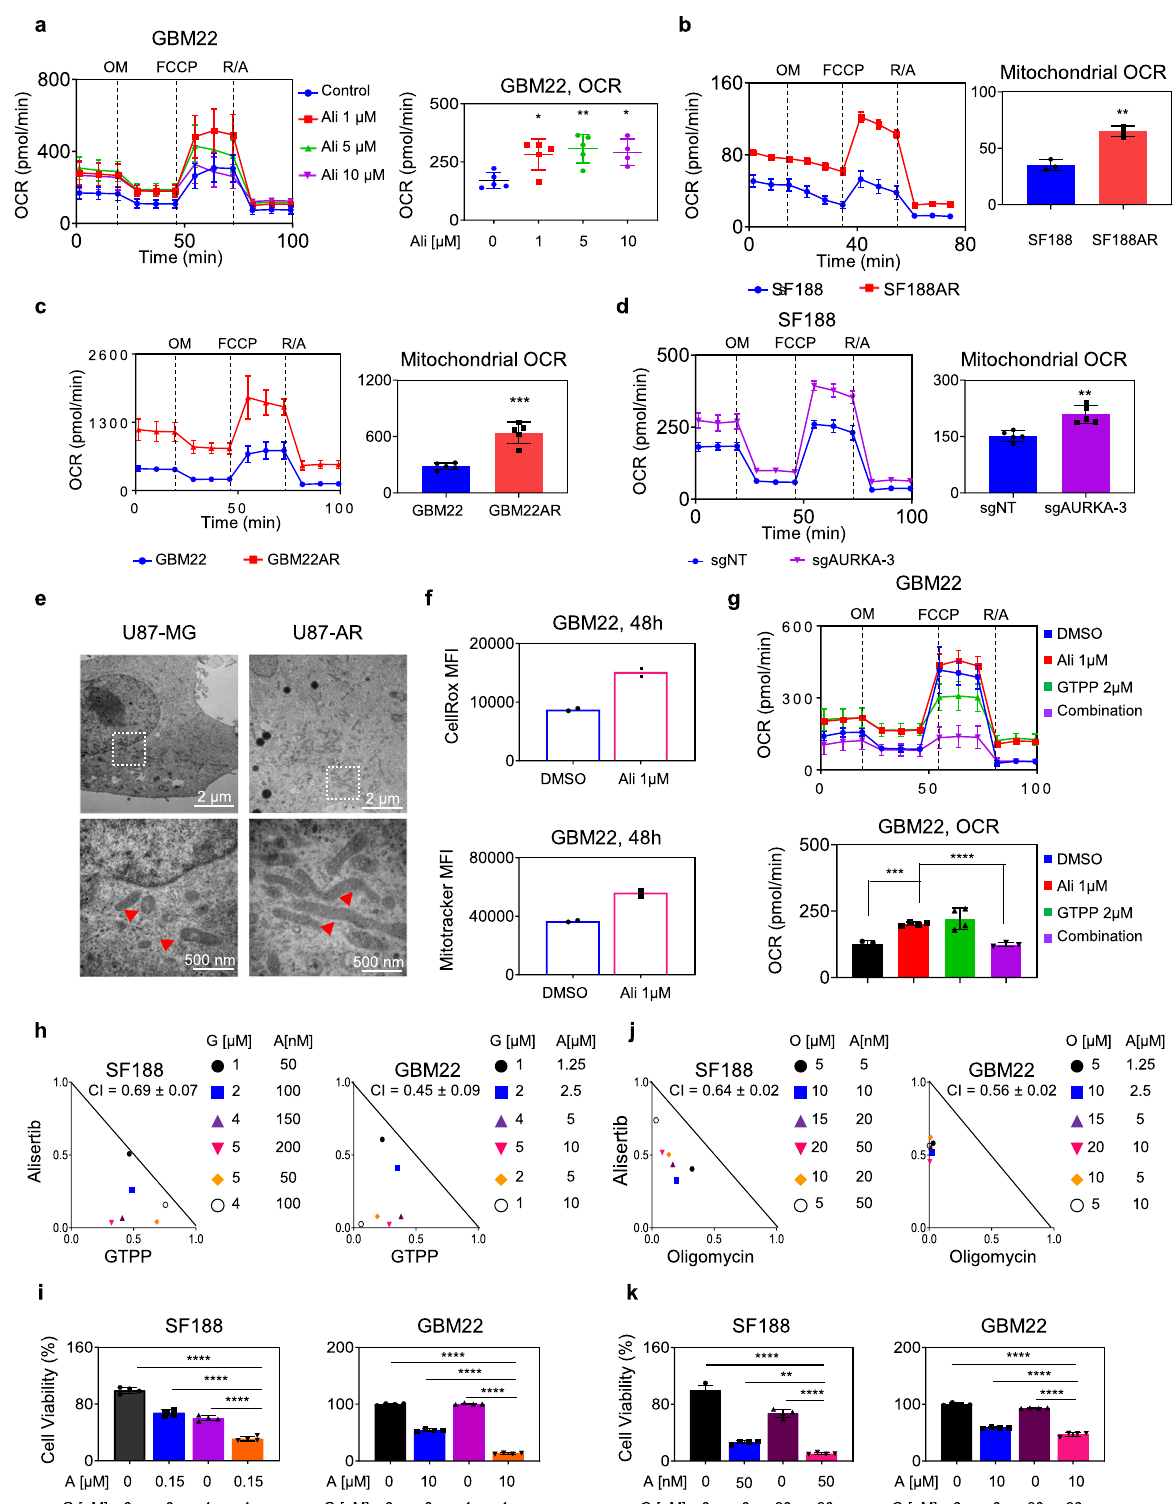
Inhibition of Aurora kinase A and oxidative phosphorylation is synthetically lethal in GBM model systems and other solid malignancies . To assess whether OXPHOS inhibition enhances the ef fi cacy of AURKA inhibition mediated reduction in cellular viability, we used several OXPHOS complex inhibitors such as gamitrinib (GTPP, blocks complex II of the respiratory chain), metformin (blocks complex I of the respiratory chain), and